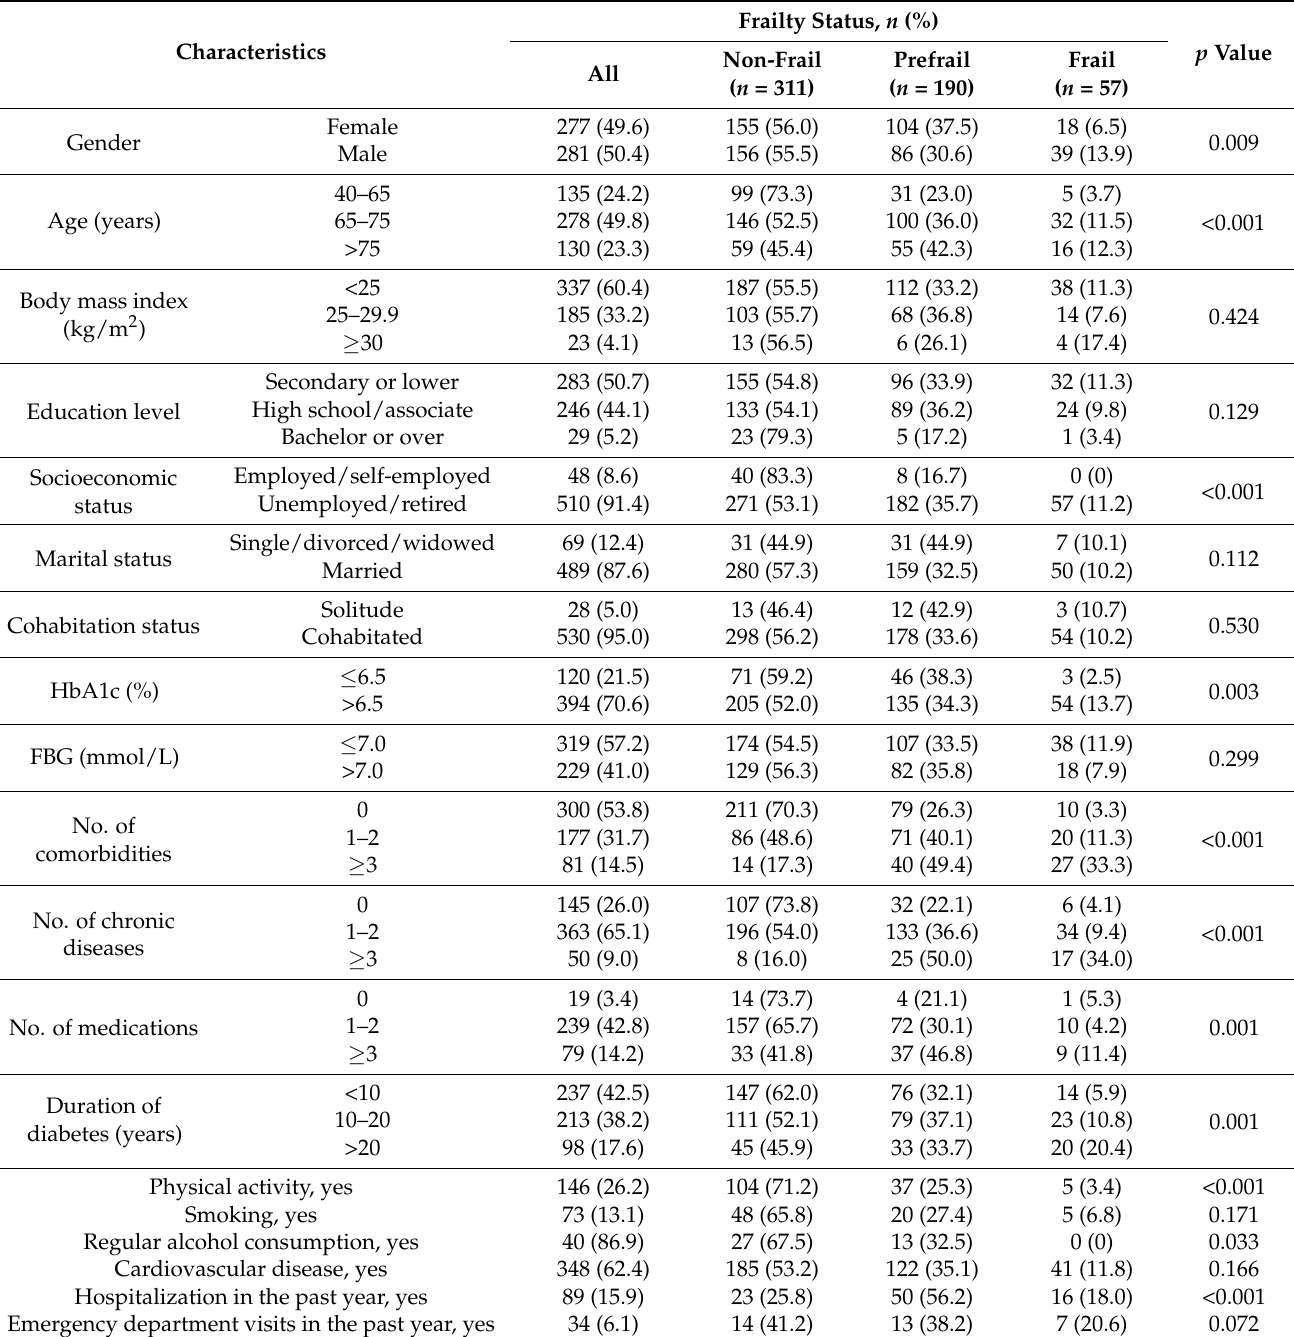
Table 1. Sociodemographic and clinical characteristics of participants, and prevalence of frailty and prefrailty in different subgroups ( n =